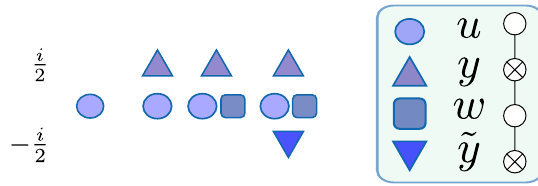
Figure 12 . The exact Bethe string basis for a fundamental magnon, describing 4 di(cid:11)erent states contained in the module. Each string is made out of the momentum-carrying root u and roots of type y; w; ~ y , each of which is associated with the Dynkin node of SU(2 j 2) shown on the right. They are represented, respectively, as circle, upper triangle, square, and lower triangle. The states are obtained by appropriately attaching the roots y; w; ~ y to the momentum carrying root, as shown in the left (cid:12)gure. These patterns of roots can be read o(cid:11) from the structure of (the generating function of) the transfer matrix [56]. For details and generalization to the bound states, see appendix C. nested Bethe equations. 15 ) In particular, this speci(cid:12)city allowed us to generate more easily the expressions for the kernels of the bound states, as explained in appendix